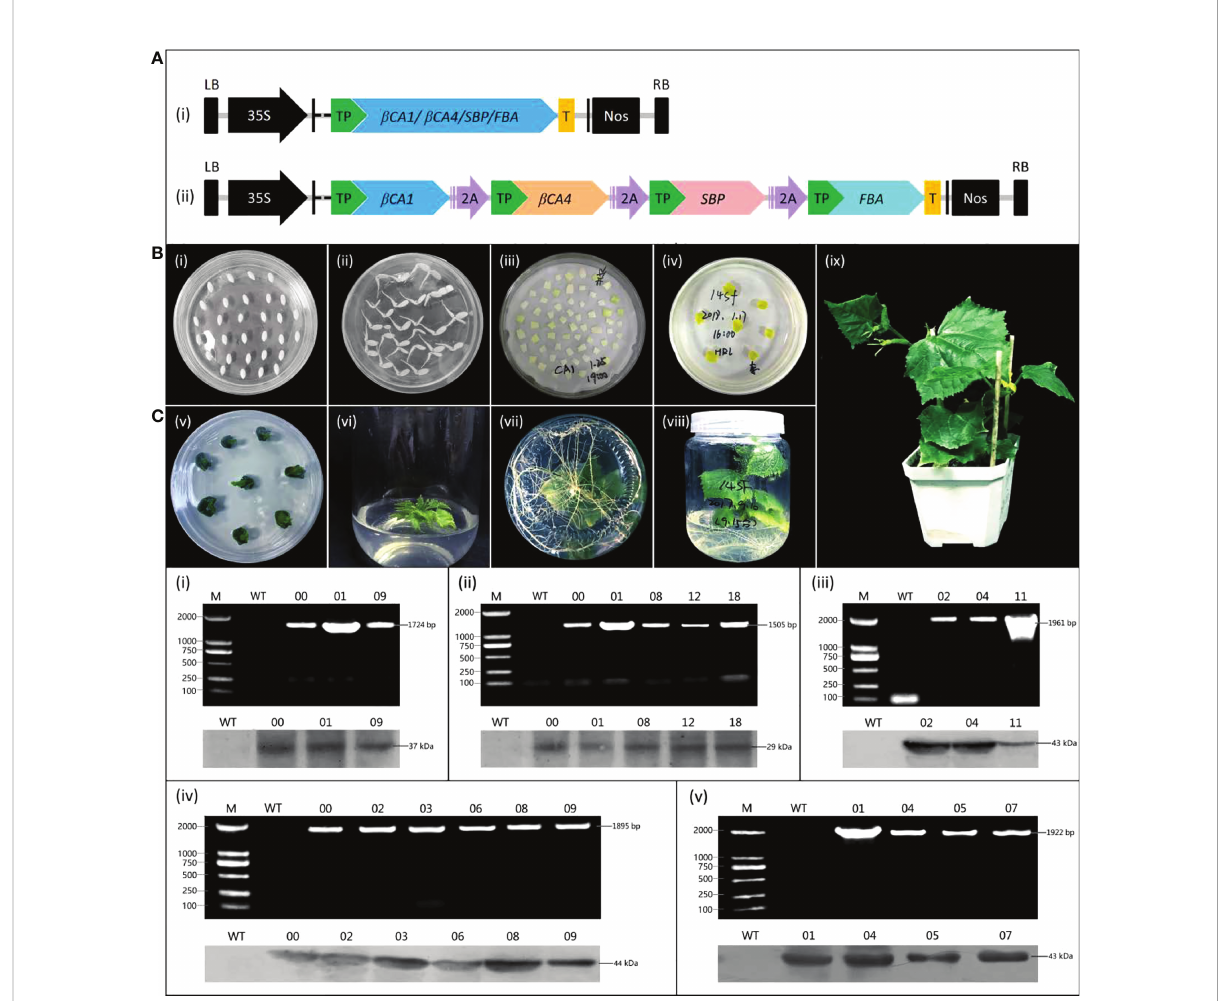
FIGURE 3 Generation and identi fi cation of transgenic plants. (A) Schematic diagram of vectors for cucumber transformation. (i) Separate expression vectors. (ii) The multigene expression vector. 2A: 2A linker peptide. TP: target peptide. T: fl ag protein tag. (B) The construction of cucumber transformation. (i) Cucumber seeds, (ii) Seed germination, (iii) Agrobacterium infection, (iv) Elimination of Agrobacterium , (v) Bud regeneration, (vi) Root induction, (vii) Roots, (viii) Regeneration of seedling, (ix) Seedling. (C) Characterization of cucumber transgenic lines, (i) Cs b CA1 , (ii) Cs b CA4 , (iii) 14SF (Four multigene overexpression transgenic cucumber plants), (iv) CsSBP , or (v) CsFBA , by PCR and Western blotting. The upper parts are the results of PCR detection, and the lower part are the results of Western blotting. M: DL2000 DNA marker. WT: the wild-type cucumber leaves. Different numbers represent plants from representative transgenic